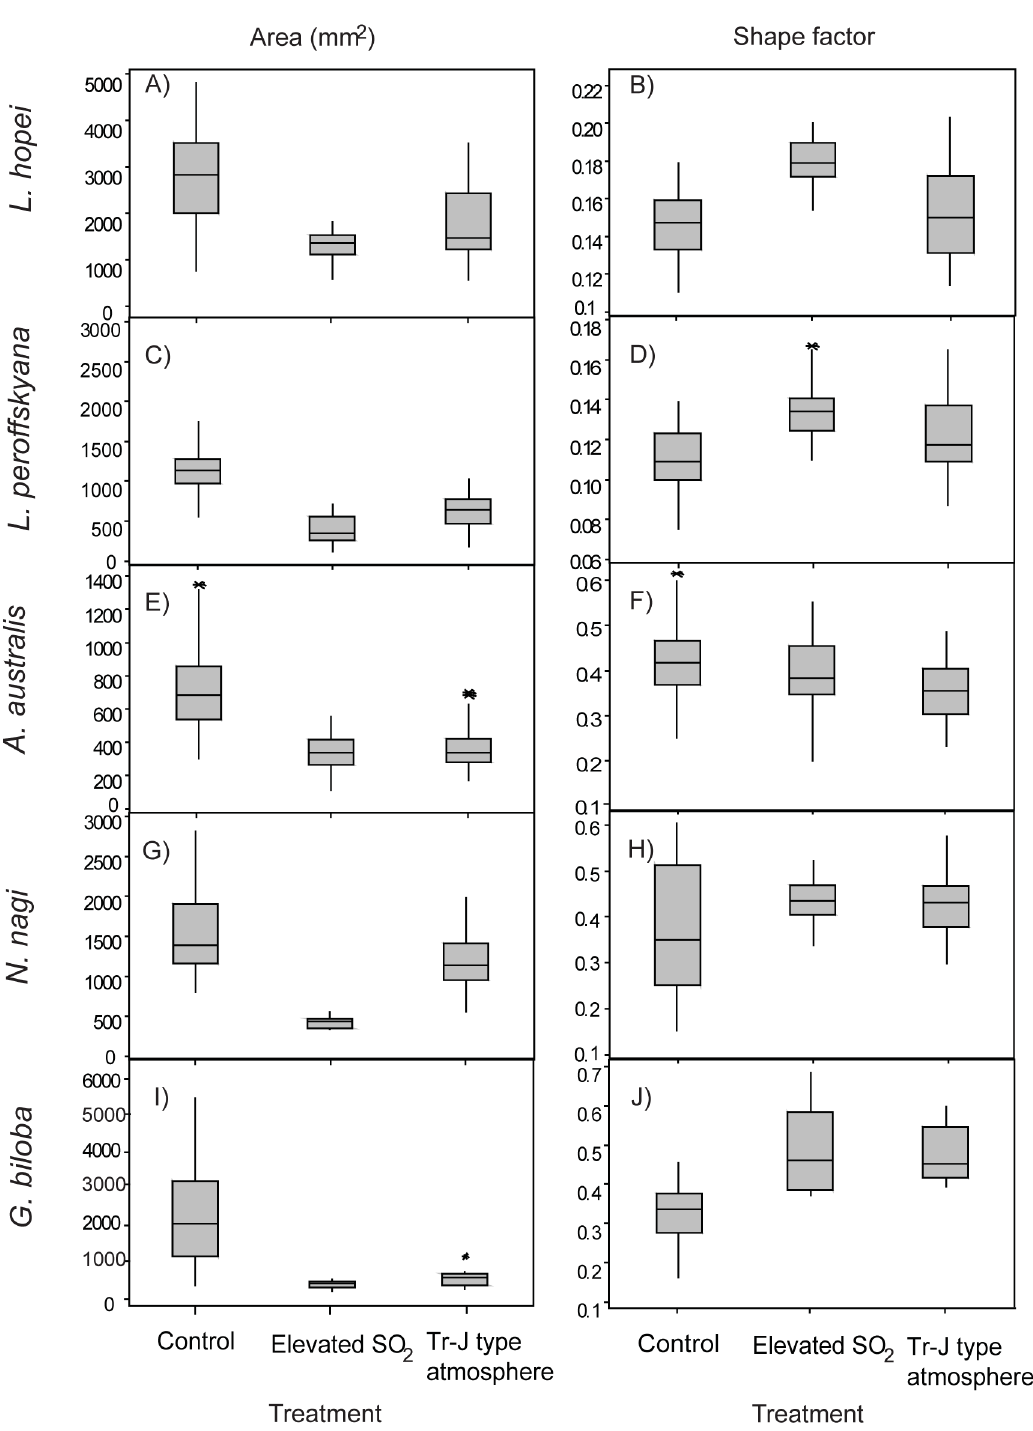
Figure 2. Box plots showing the range of values for area and shape factor for each nearest living equivalent species. The box represents the lower 25 percentile, the median value and the upper 25% percentile and the whiskers represent the range of the data. Stars represent outliers (values over twice the value of the median). Lepidozamia hopei (A area and B shape factor); L. peroffskyana (C area and D shape factor); Agathis australis (E area and F shape factor); Nageia nagi (G area and H shape factor); Ginkgo biloba (I area and J shape factor). doi:10.1371/journal.pone.0060614.g002 relative abundance of each taxon [25], and reveals a clear pattern throughout the Astartekløft section within each genus investigated. of increasing shape factor, followed in the next bed by a decrease in relative abundance of the taxon. For example, Ginkgoites has its Figure 4 compares the changes in shape factor to variations in